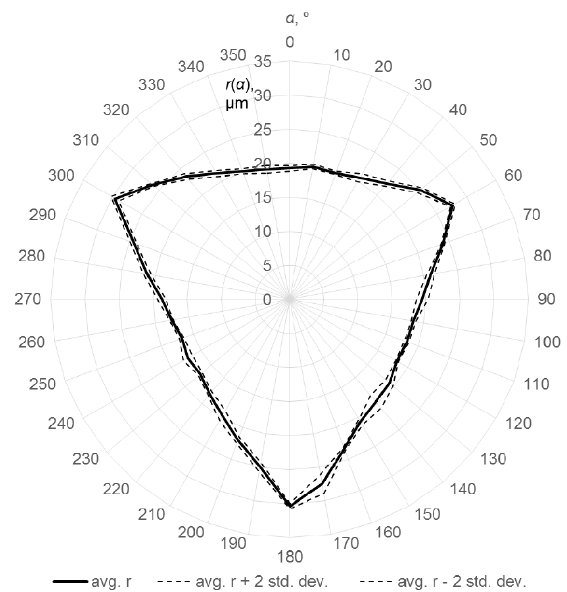
Figure 3. Results obtained in the laboratory for compact touch-trigger probe with a 50 mm stylus.